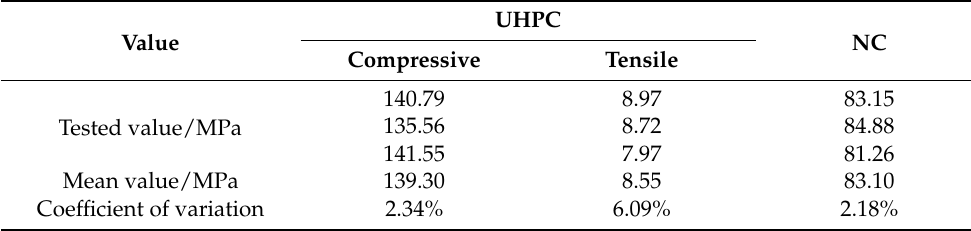
Table 1. Strength of the tested